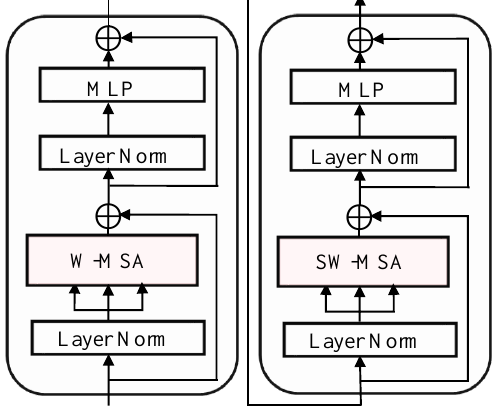
Figure 3. Two successive Swin Transformer